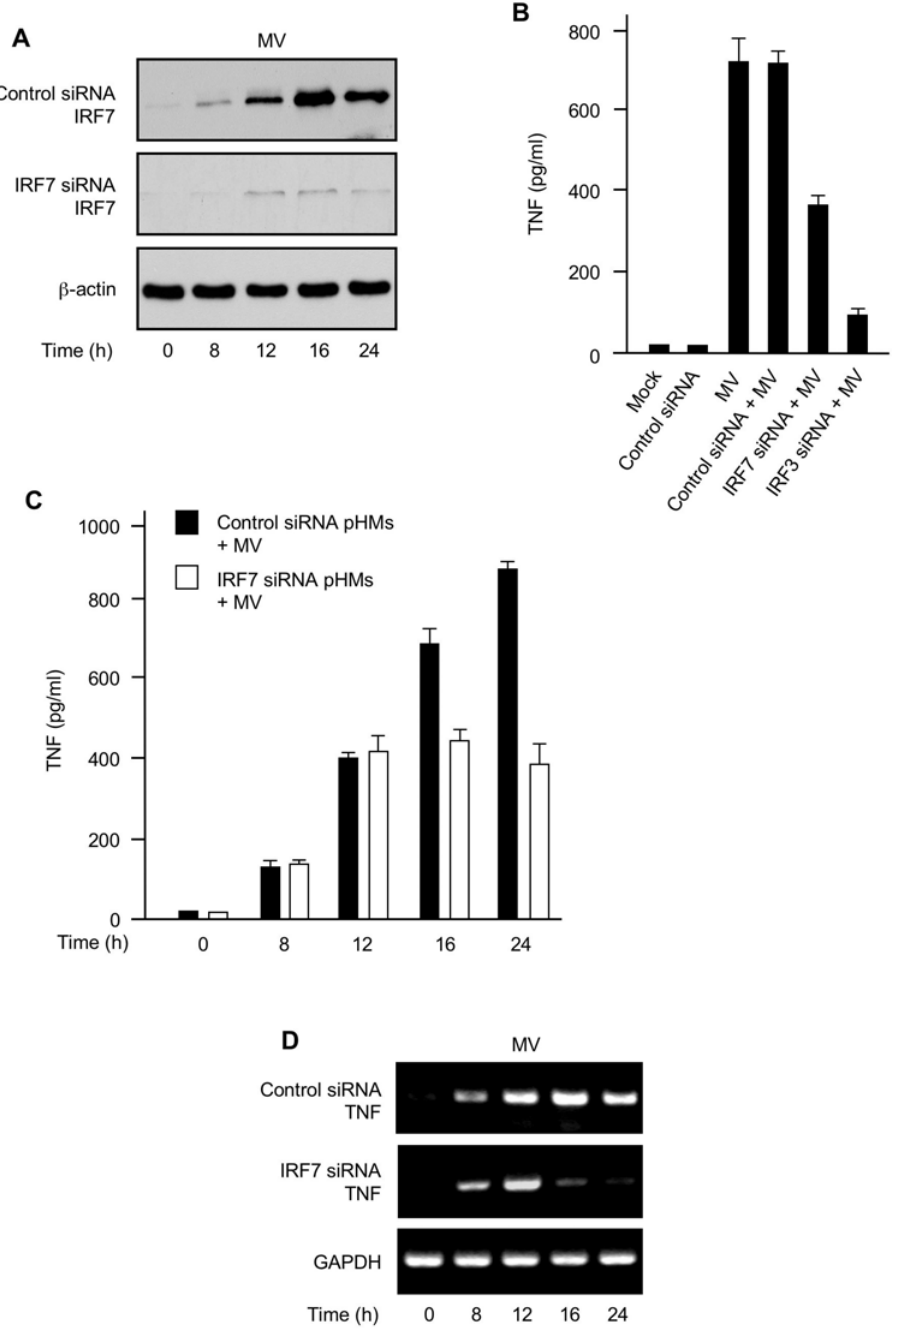
Figure 5. IRF7 is crucial for sustaining MV-elicited TNF induction in primary human macrophages. (A) Control siRNA pHMs or IRF7 siRNA pHMs were infected with MV for various times (below lanes) and the whole cell lysates were analyzed for MV-induced expression of IRF7 protein. b - actin was used as control. (B) pHMs or various siRNA pHMs were mock-infected or infected with MV. TNF protein in the culture supernatants was assessed by ELISA 24 h post-infection. (C) IRF7 expression and TNF production kinetics. Control siRNA pHMs or IRF7 siRNA pHMs were infected with MV for various times as indicated and TNF protein in the culture supernatants was assessed by ELISA. (D) IRF7 is required for sustaining TNF gene transcription activated by MV infection. Control siRNA pHMs or IRF7 siRNA pHMs were infected with MV for various times (below lanes) and the cells were analyzed by RT-PCR for the indicated TNF mRNA levels. GAPDH was used as control. Data in (B) and (C) represent mean + / 2 SD.